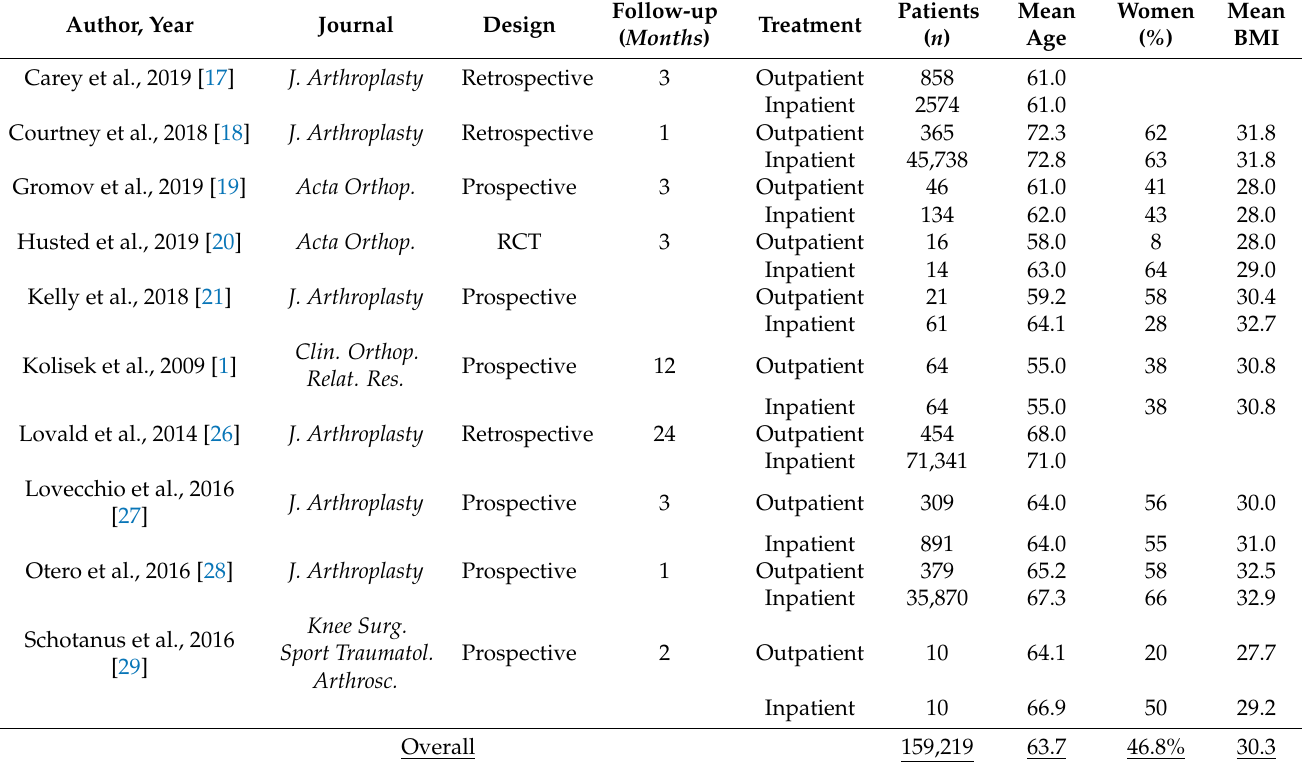
Table 2. Generalities and patient baseline of the included studies.